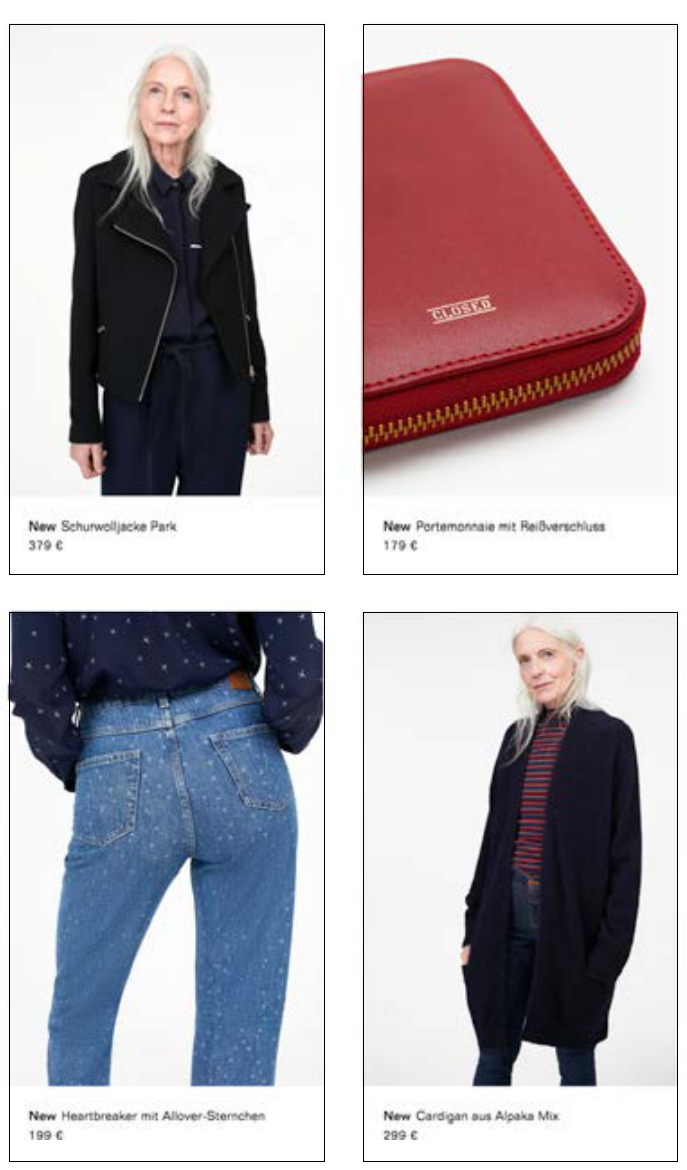
Figure 11: There are also counter-examples that break through these gender stereotypes. Exemplary for this is the German fashion label closed (closed.com) that presents younger and older female models in a natural, appreciative manner. Source: www.closed.com. Accessed: November 27,